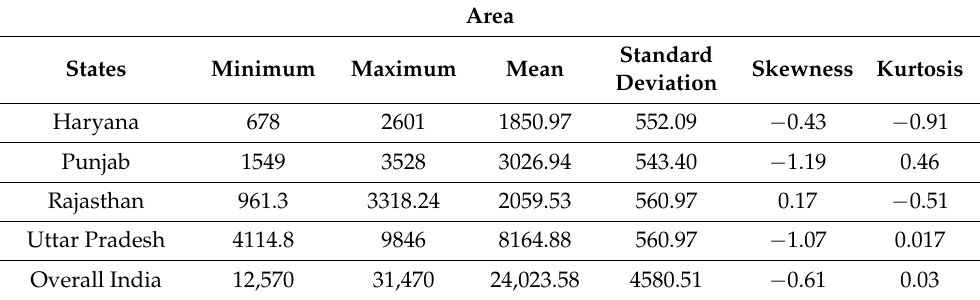
Table 7. Summary statistics of area under cultivation of the wheat (thousand hectares).